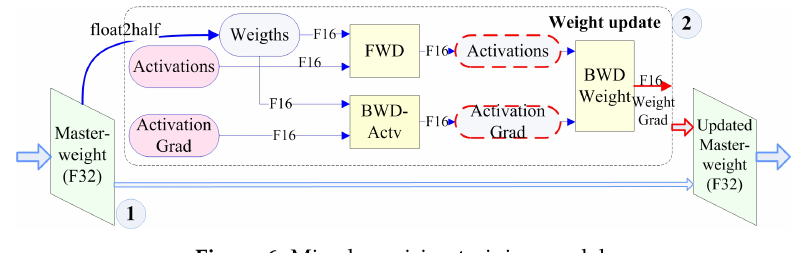
Figure 6. Mixed-precision training